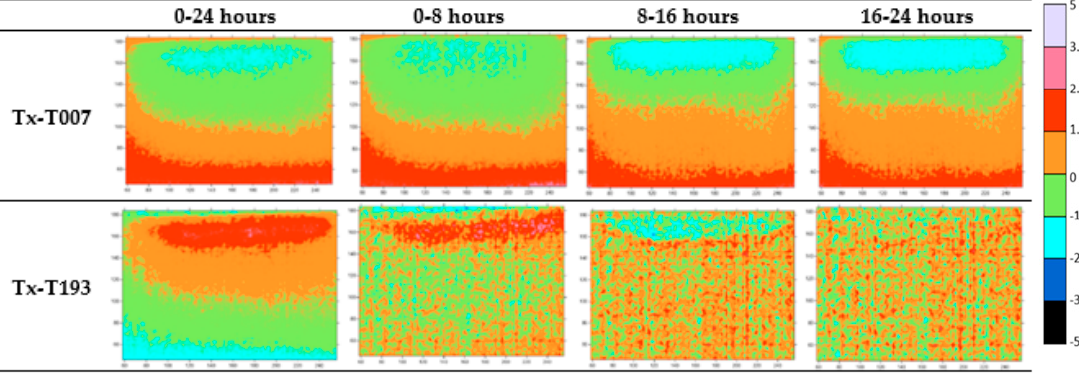
Figure 2. First Principal Component considering the four periods of analysis (0-24 hours, 0-8 hours, 8-16 hours and 16-24hours) and the two reference instants for image subtraction (T007 and T193). Table 3. Number of Principal Component (PC) and respective percentage of explained variance. Explained variance Tested scenario Number of PC